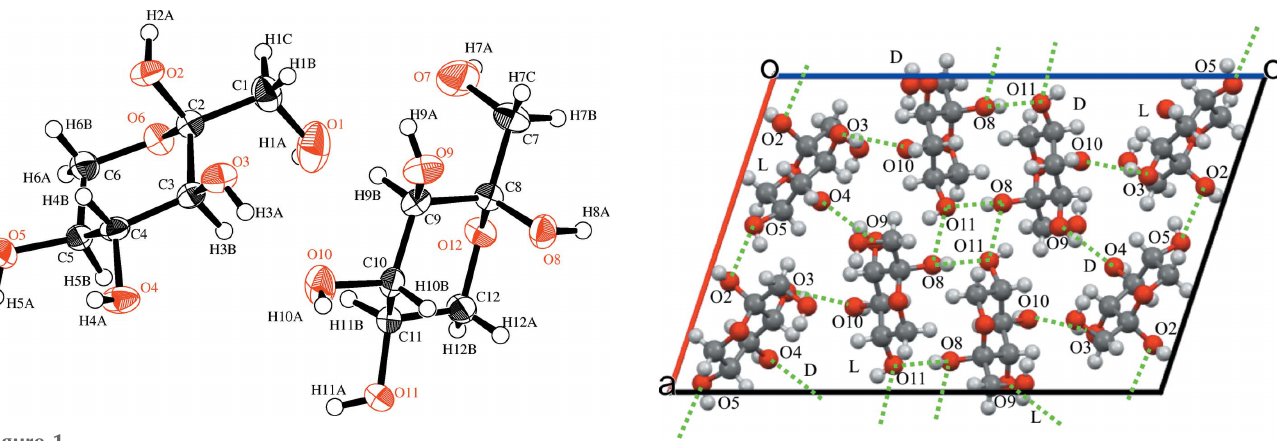
Figure 2 A packing diagram of the title compound viewed down the b axis, showing the hydrogen-bonding network (dotted lines). In this figure, D and L denote the d - and l -forms, respectively.